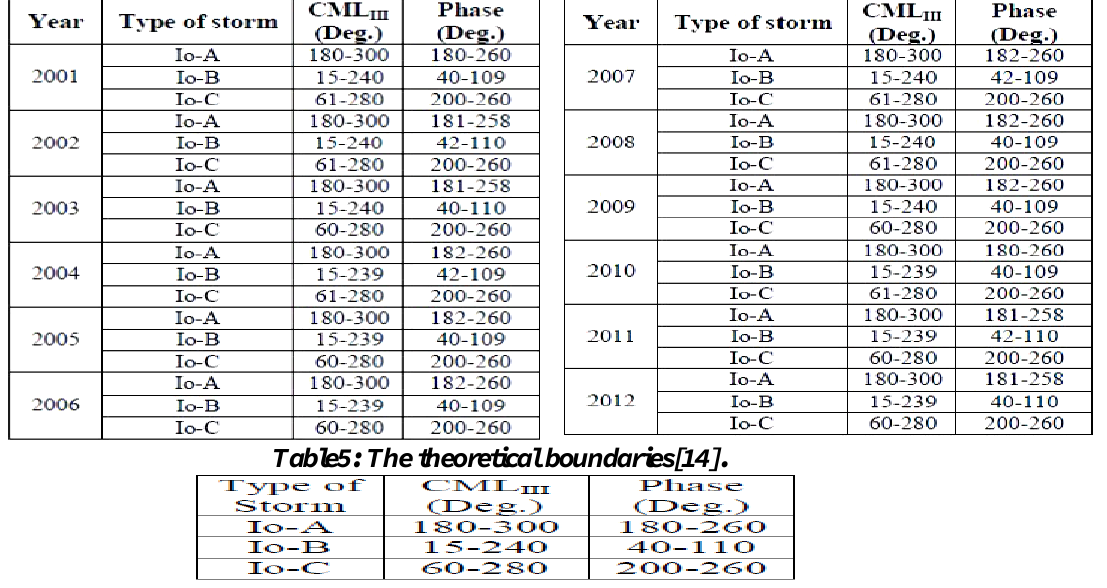
Table4: The boundaries for multi years from the observations.